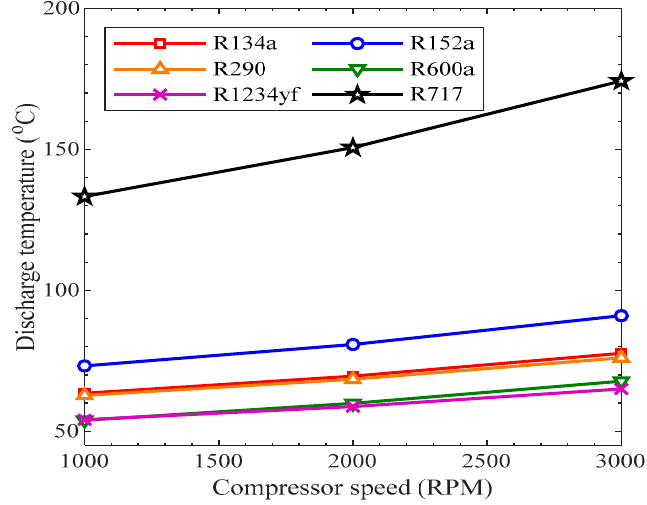
Figure 10. Discharge temperature vs. compressor speed .